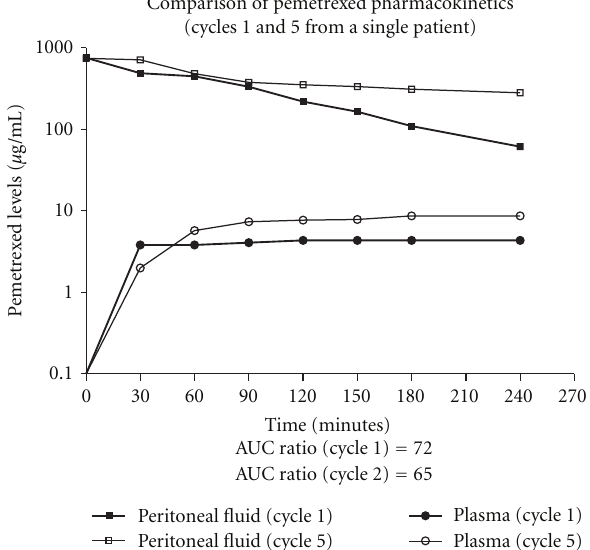
Figure 2: Concentration times time graph of intraperitoneal pemetrexed in peritoneal fluid and plasma in a single patient who had pharmacologic studies of the first and fifth